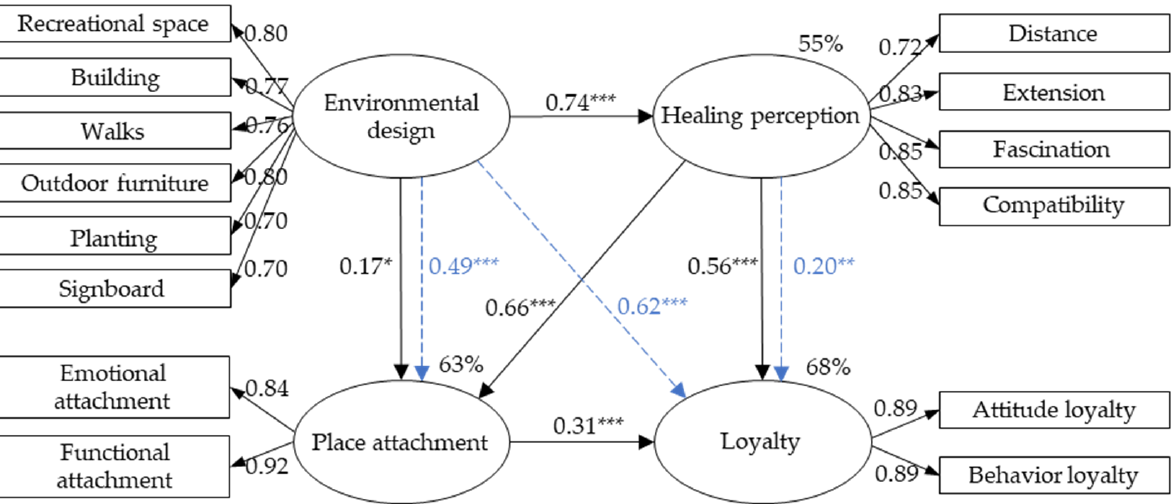
Figure 3. The suggested model of the relationships among environmental design, healing perception, place attachment, and place loyalty. The dashed lines indicate the indirect effects between the pair of constructs. * p < 0.05; ** p < 0.01; *** p < 0.001.